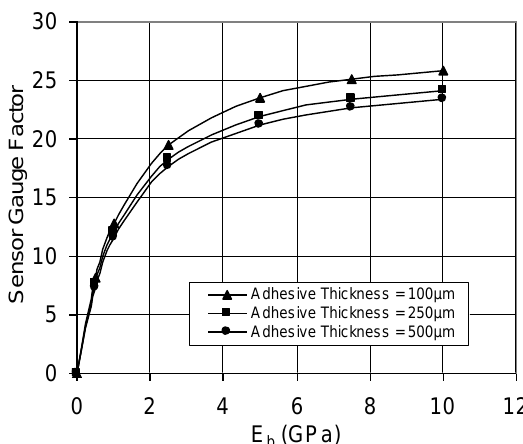
Figure 8. Effect of adhesive material properties (modulus of elasticity, E gauge factor, V = 5 i